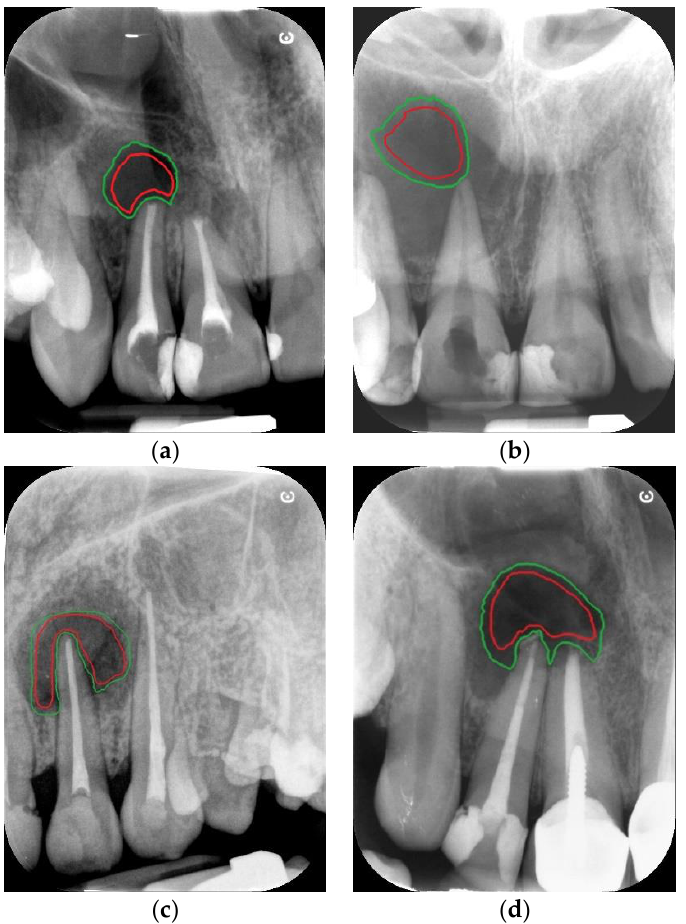
Figure 2. Example of ROI outlines: for granulomas ( a , c ), for cysts ( b , d ). Legend: red for the lesion interior outline, green for the outline including the lesion edges.